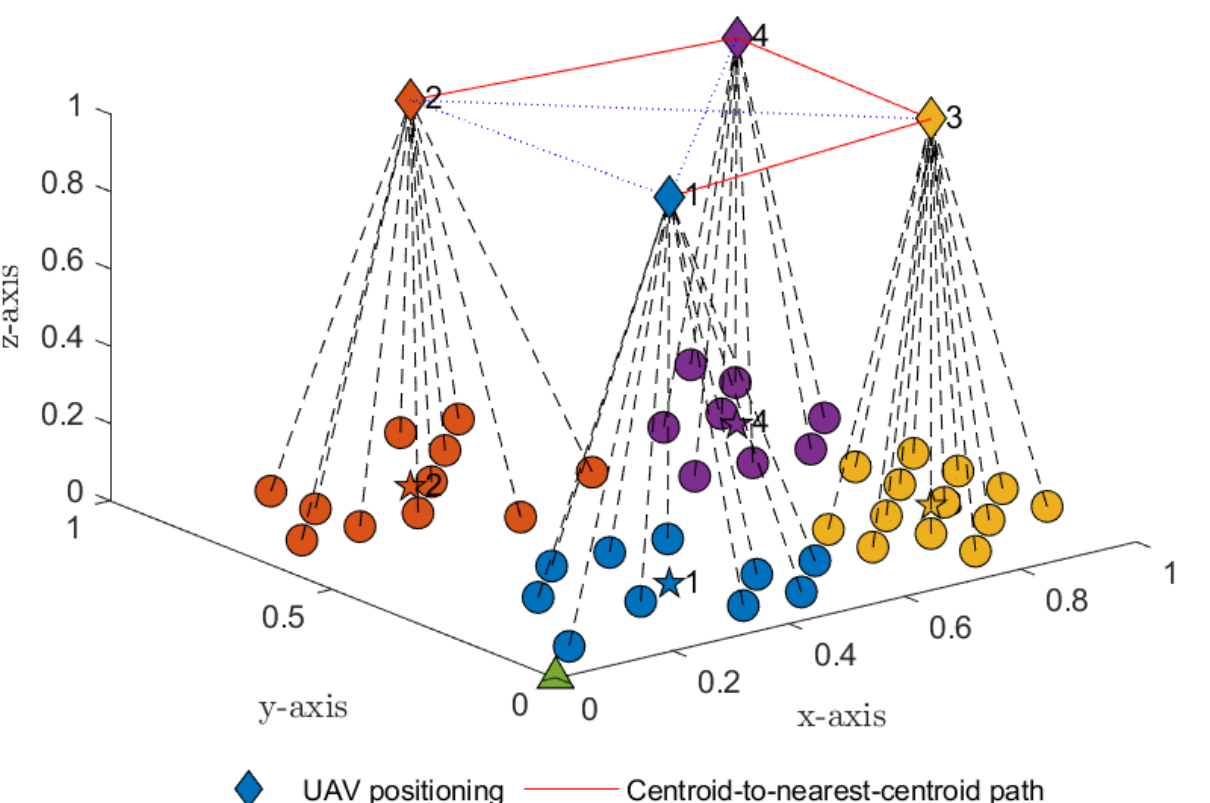
Figure 4. Joint UAV trajectory and the shortest path based on the centroid-to-next-nearest-centroid distance given by Algorithm 1 (i.e., C 1 → C 3 → C 4 → C 2 ). Algorithm 1 K -means clustering for the optimal number of subclusters and shortest path determined from a centroid to the next nearest